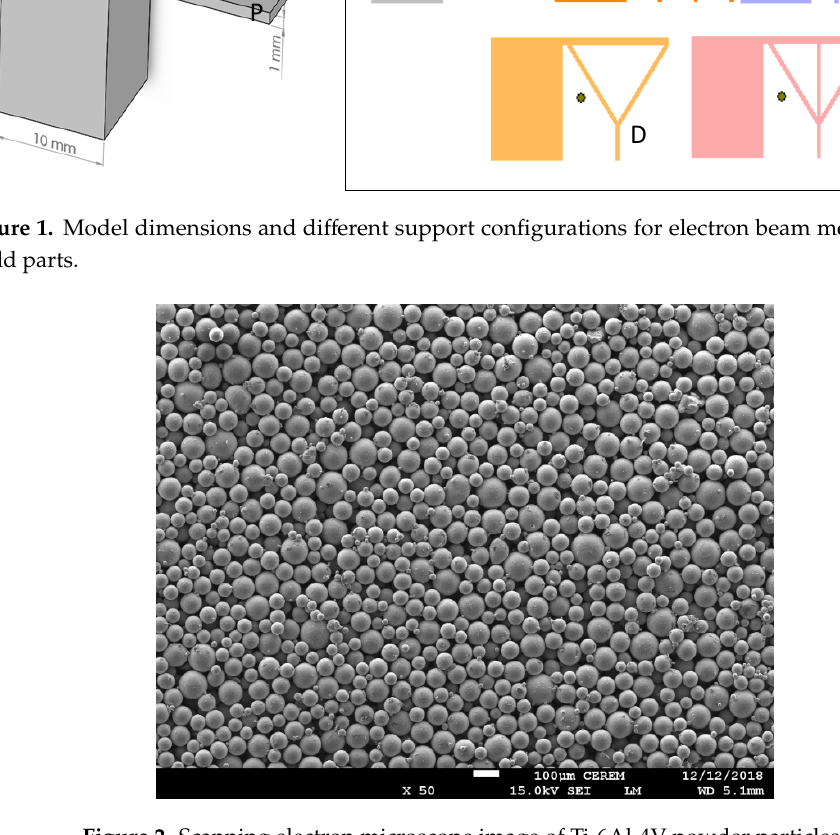
Figure 2. Scanning electron microscope image of Ti-6Al-4V powder particles.